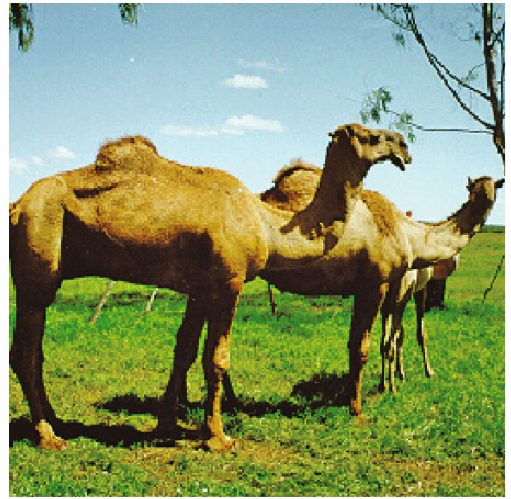
Figure 4: The Pakistani breeds. Source: [17] (with permission from authors). Table 3: Comparison of camel milk production among